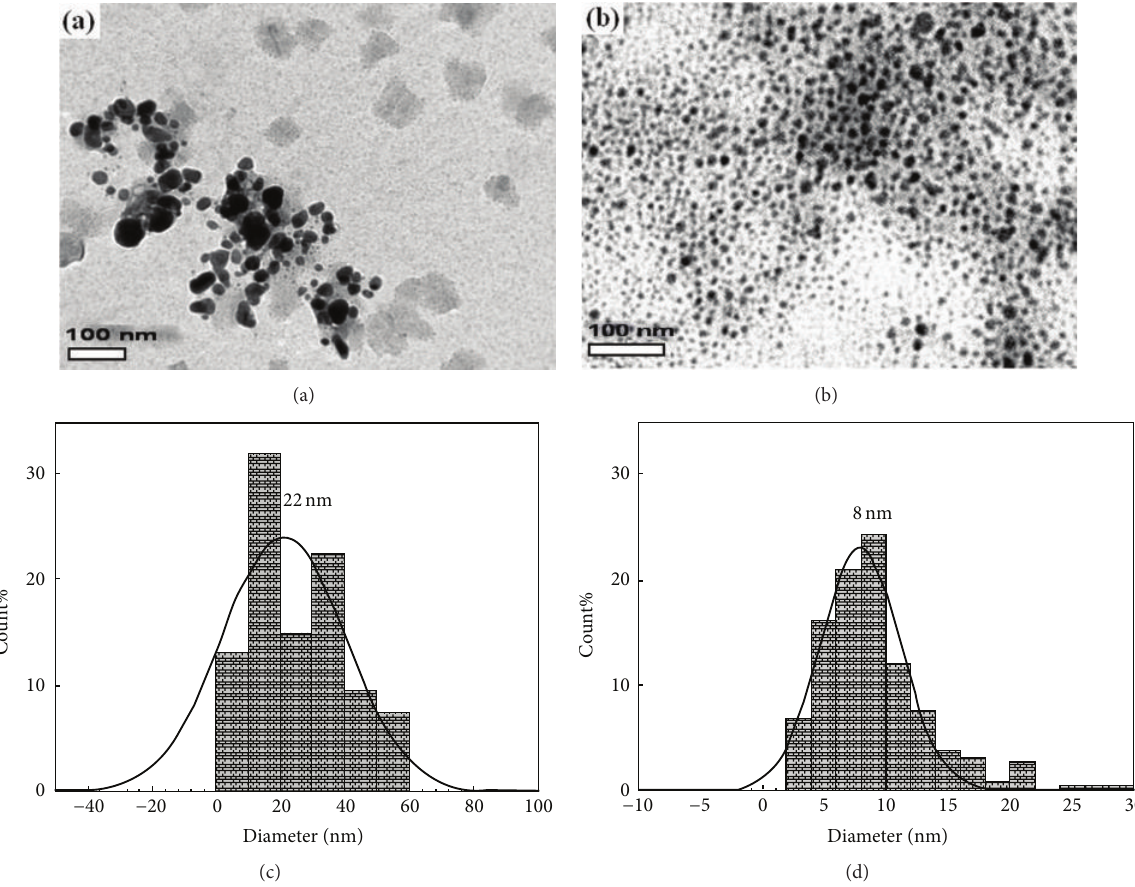
Figure 6: TEM micrographs of the as-prepared Ag-NPs (a) without and (b) with PAA and its corresponding histograms with Gaussian fitting (c) and (d), respectively.